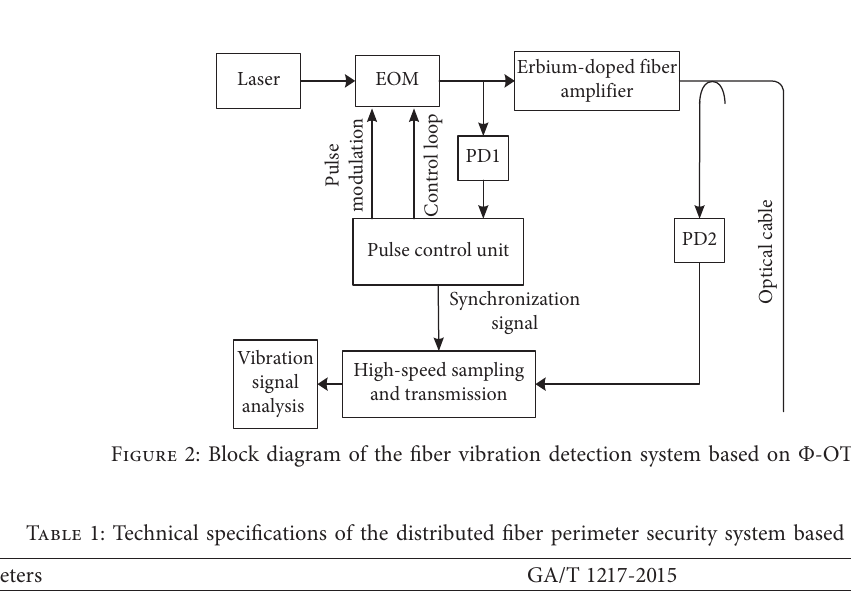
Figure 1: Overall structure connection diagram of fiber perimeter security system based on Φ -OTDR.